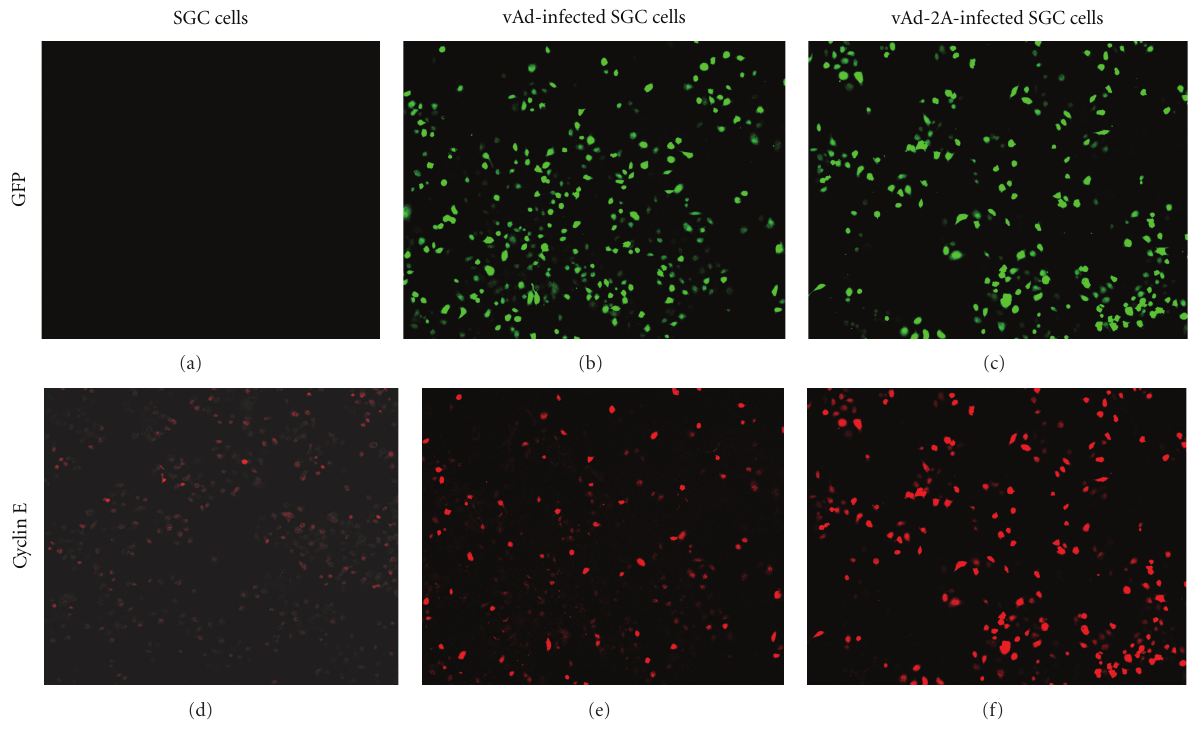
Figure 7: Confocal analysis for cyclin E on SGC cells.